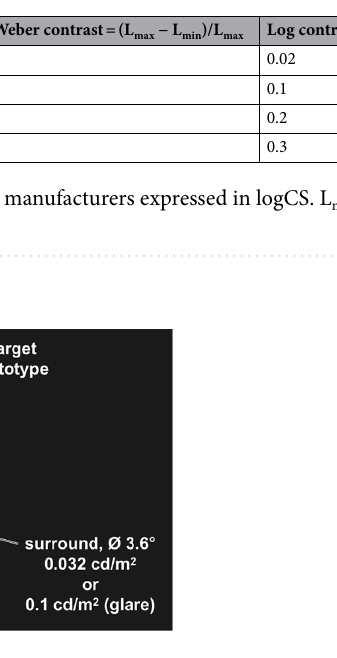
Figure 2. Participants’ view in the Mesotest II (Oculus GmbH, Wetzlar Germany) during testing. Adapted from instruction manual for Mesotest II (Oculus GmbH, Wetzlar